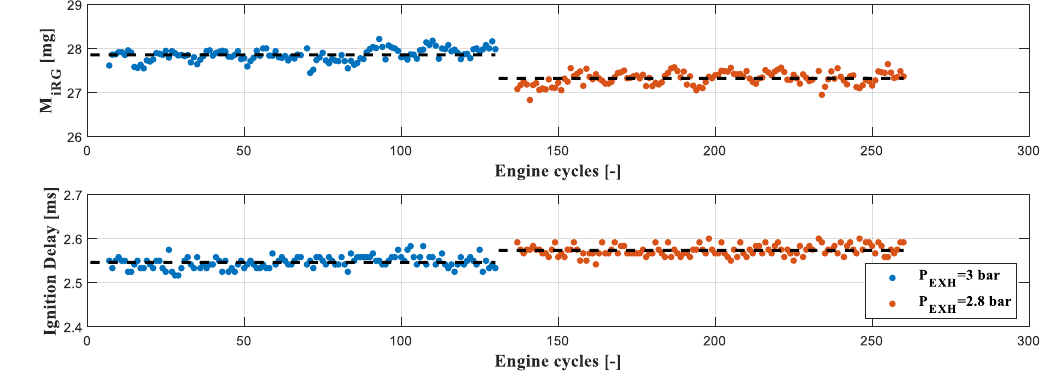
Figure 11. Effect of different residual gas masses on ID.